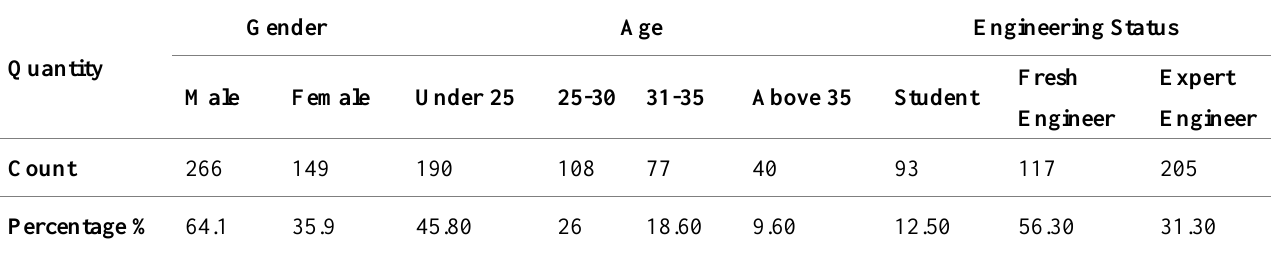
Table 1 . Demographic Information of the Participants